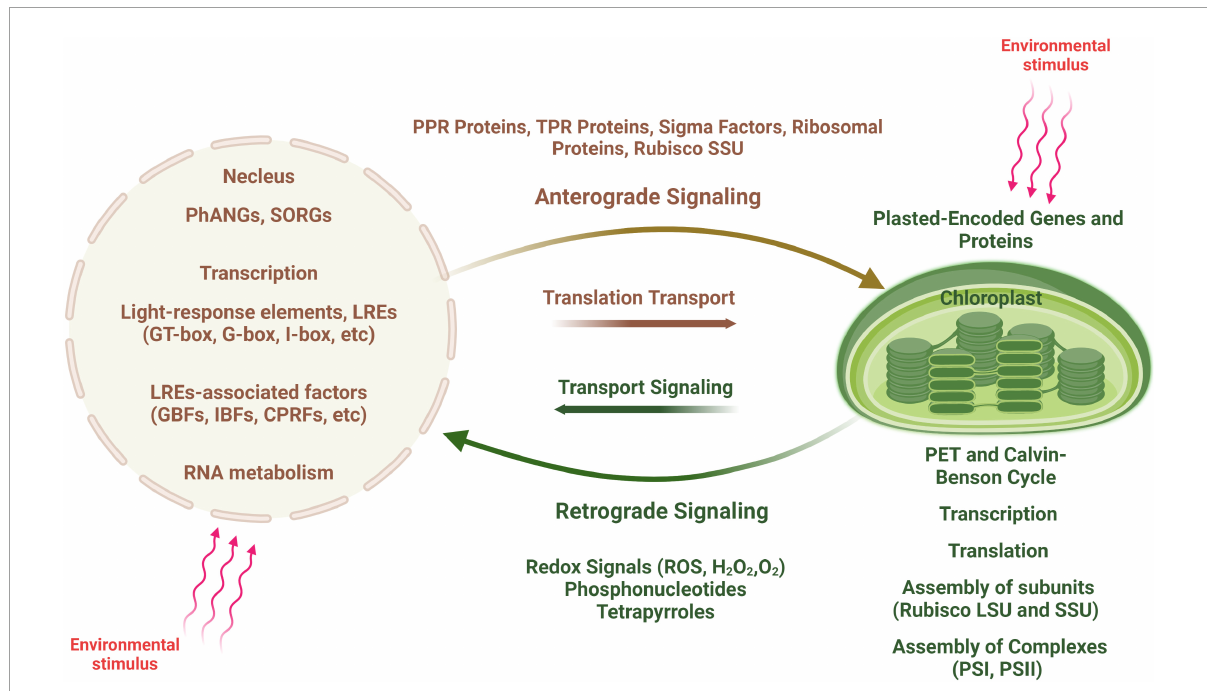
FIGURE4 Scheme of anterograde and retrograde signaling in plant cells. An environmental stimulus is perceived by the nucleus, communicated to the chloroplast (shown by red arrows) and leads to changes in chloroplast transcription (anterograde signaling). In contrast, signals generated by the chloroplast are transduced to the nucleus causing changes in nuclear gene expression (retrograde signaling), in particular to regulate the expression of nucleus-encoded photosynthesis associated nuclear genes ( PhANGs ).